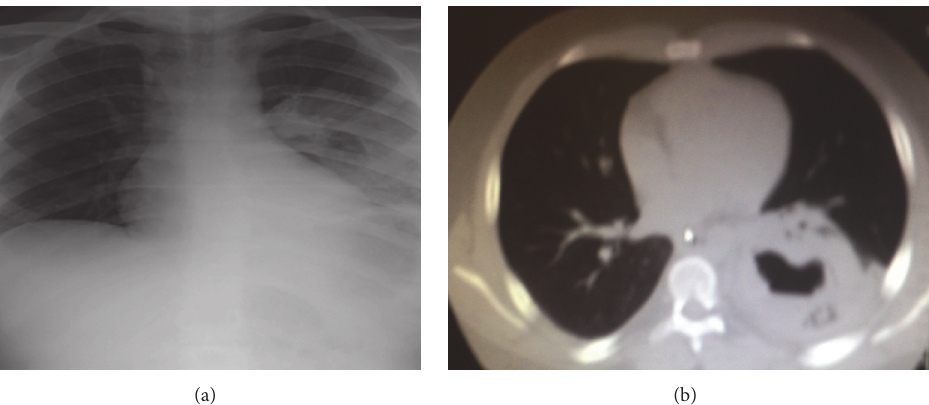
Figure1:(a)InitialchestX-rayoninitialpresentationforan18-year-oldmanstatusaftercadaverickidneytransplantdemonstratingincreased opacification of the mid and lower left lung fields. (b) Computerized topography of chest/thorax for the same patient demonstrating a left lobe cavitary